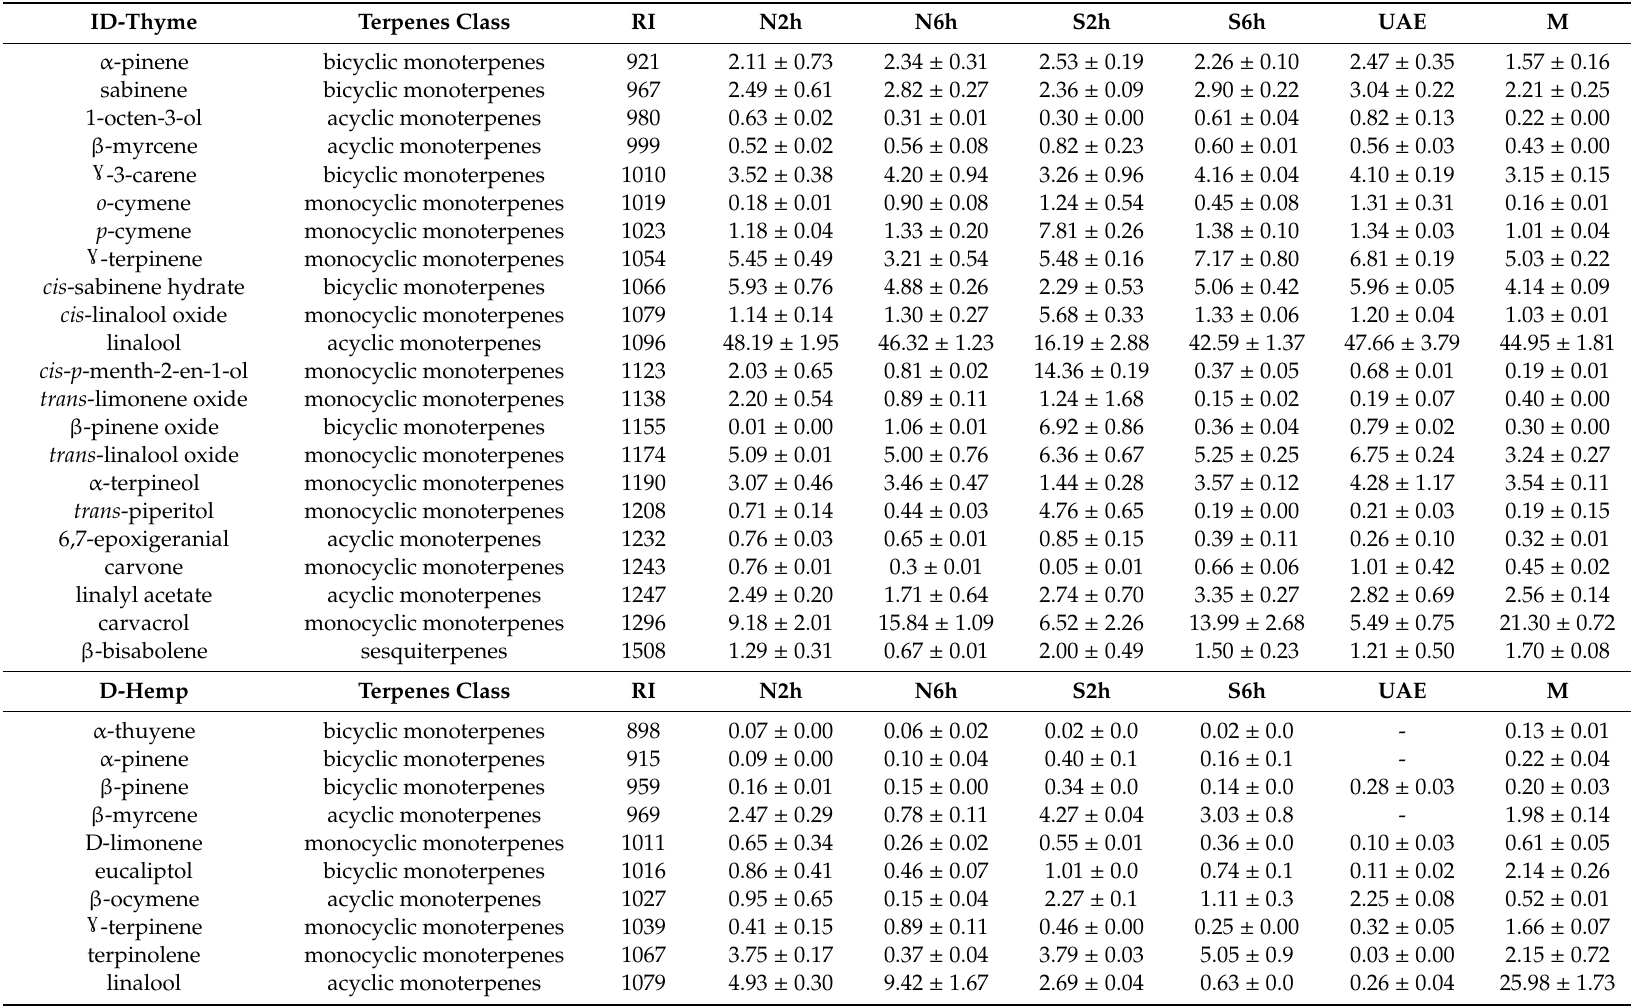
Table 2. Solid-phase microextraction/gas chromatography-mass spectrometry ( SPME/GC-MS) characterization of the volatile fraction of thyme, hemp and coriander seeds extracts. Results are expressed as relative abundances % (means ± sd).